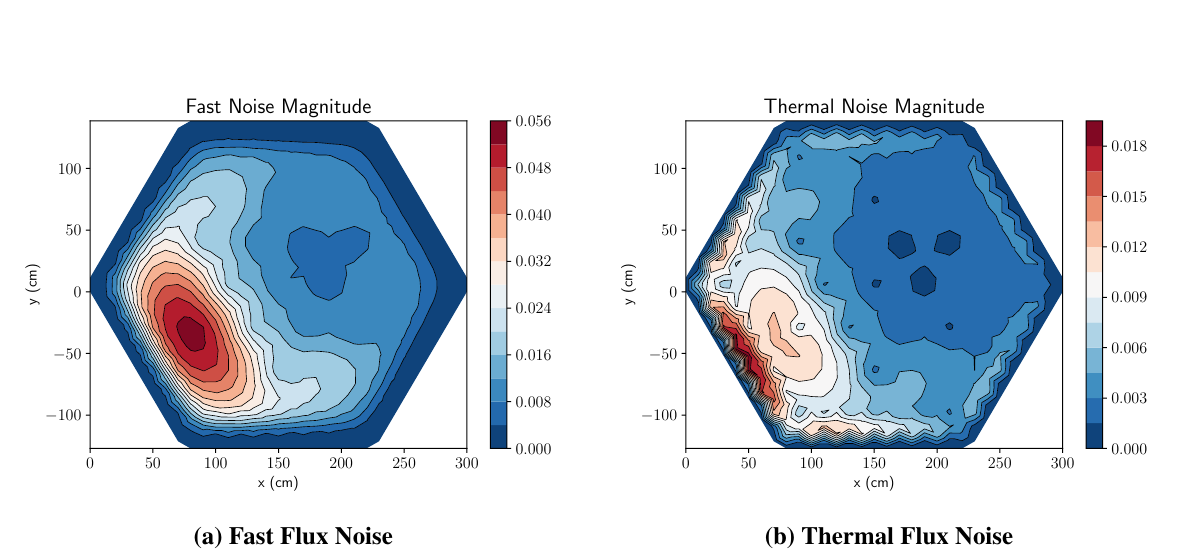
Figure 3: Magnitude of the noise in the 2D IAEA reactor.